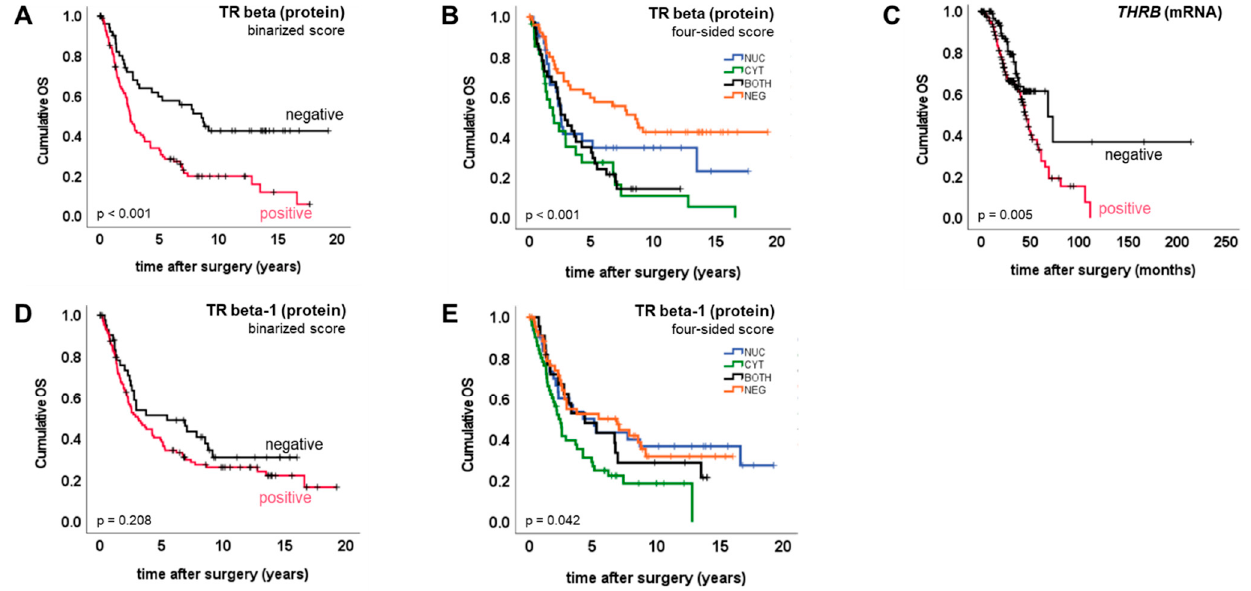
Figure 3. TR beta/TR beta-1 and overall survival. Kaplan–Meier plots ( A – E ) were drawn to illus- trate overall survival of patient subgroups defined by TR